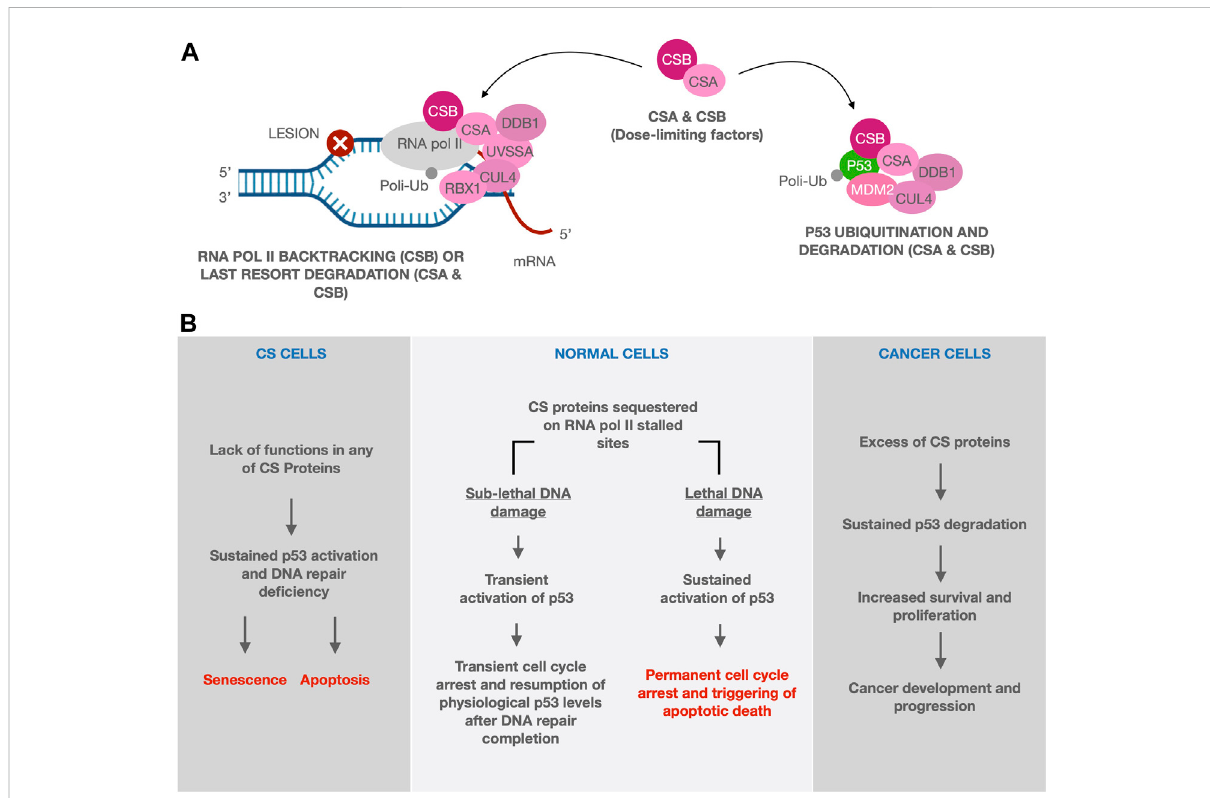
FIGURE 2 The biological predictor role of CS proteins. In our model CS proteins, which are alternatively involved in DNA repair or p53 ubiquitination/ degradation, act as dose-limiting factors. When a cytotoxic lesion occurs, CS proteins, together with the TCR machinery, are transiently recruited at the level of the stalled RNA pol II, whose backtracking or degradation will allow the repair in case of sub-lethal damage. In this context, p53 is not ubiquitinated anddegradedanditisfreetoinduceatransientcellcyclearrest,inthosecellsreceivingsub-lethalDNAdamage.Cellcyclewillbe then restored upon the completion of DNA repair when CS proteins, being no longer engaged in TCR, will be able to re-establish the basal level of p53 throughitsubiquitinationanddegradation.Ifcellsare exposedto lethal damage/stress,instead, theywill undergo an irreversible cell cyclearrest followed byapoptosis,due tothesustained activation ofp53.Inthiscase, CSproteinsaccumulate andpersist atthedamagedsitesand,as aresult of this entrapment, p53 may not be ef fi ciently degraded [ (A,B) central panel]. When CS role as biological predictors is missing, as in the context of CS cells, the lack of p53 degradation leads to a massive induction of apoptosis [ (B) left panel]. Instead in cancer cells, where CS proteins are overexpressed, abnormally high levels of p53 degradation are induced, thereby promoting development and progression of cancers, by shifting the cell fate toward survival and proliferation rather than apoptosis [ (B) right